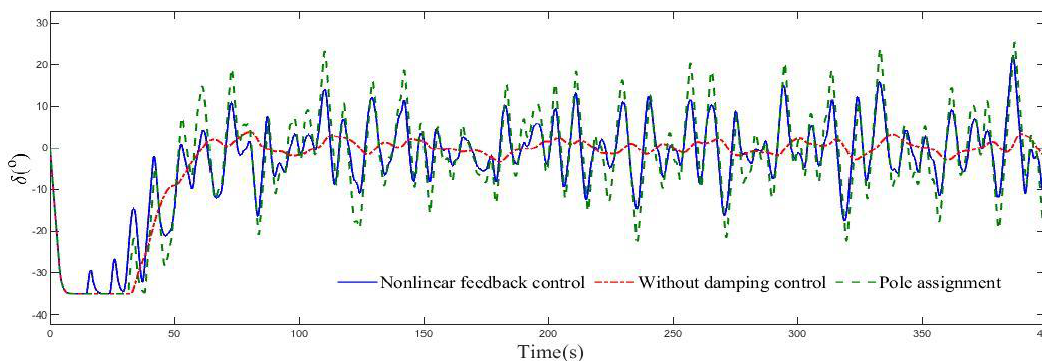
ff erent control.